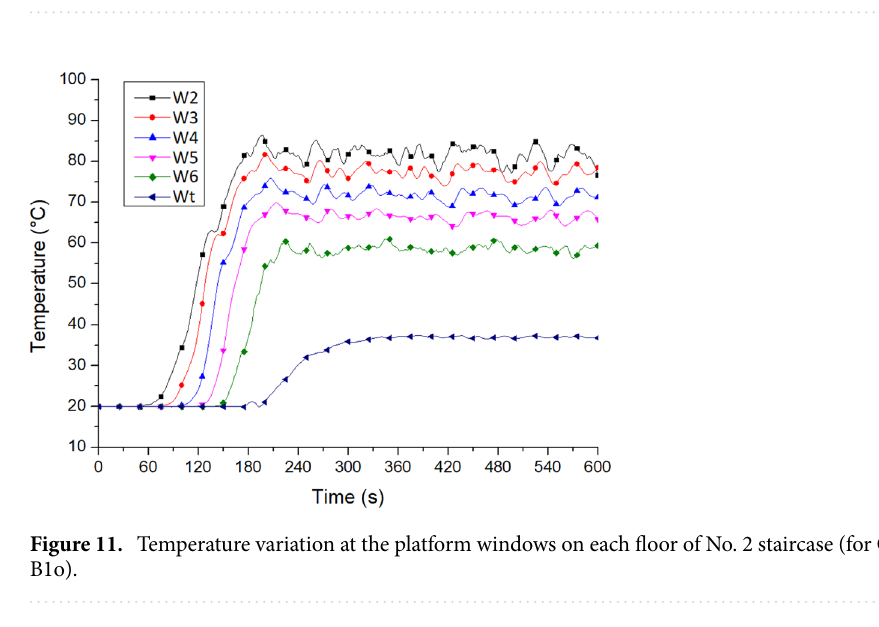
Figure 10. Heat release rate of each case.